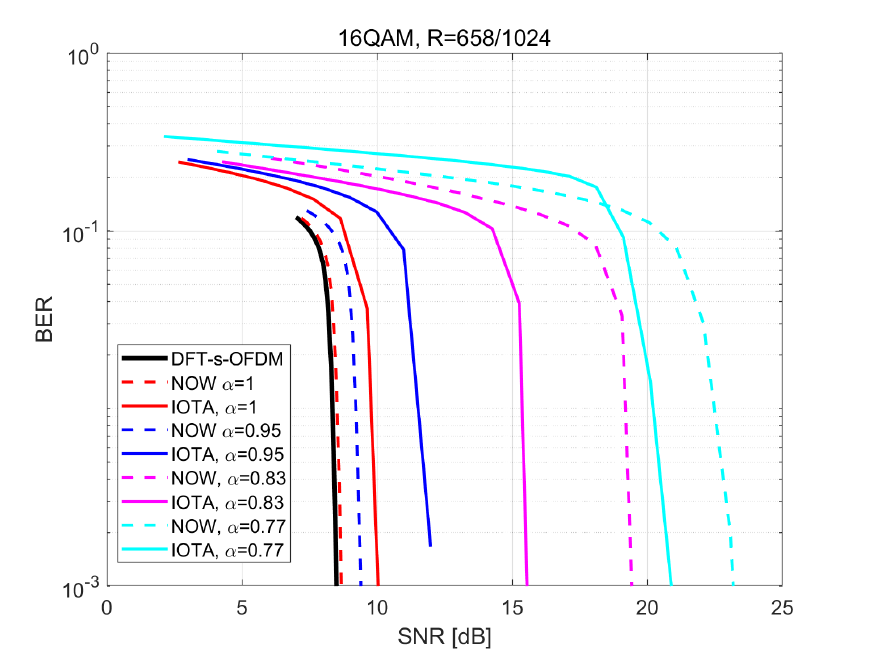
Figure 12. Performance of BER based on 16QAM with R = 658/1024.